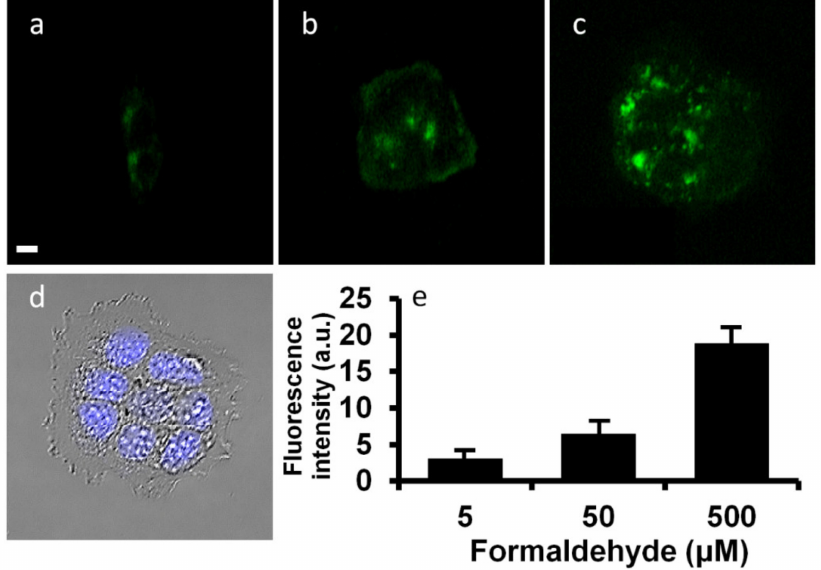
Figure 3. The fluorescence imaging of FA in live MCF7 cells using the probe EW2. The MCF7 cells were incubated with ( a ) 5, ( b ) 50, and ( c ) 500 µ M FA for 30 min followed by 5 µ M of probe EW2 for 40 min. The image in ( d ) is the bright-field image of the cells in ( c ) overlaid with an image stained with 5 µ g/mL Hoechst 33342. The scale bar represents 50 µ m in all images. ( e ) The mean fluorescence intensities of representative images with 5 µ M EW2 with varying concentrations of FA.